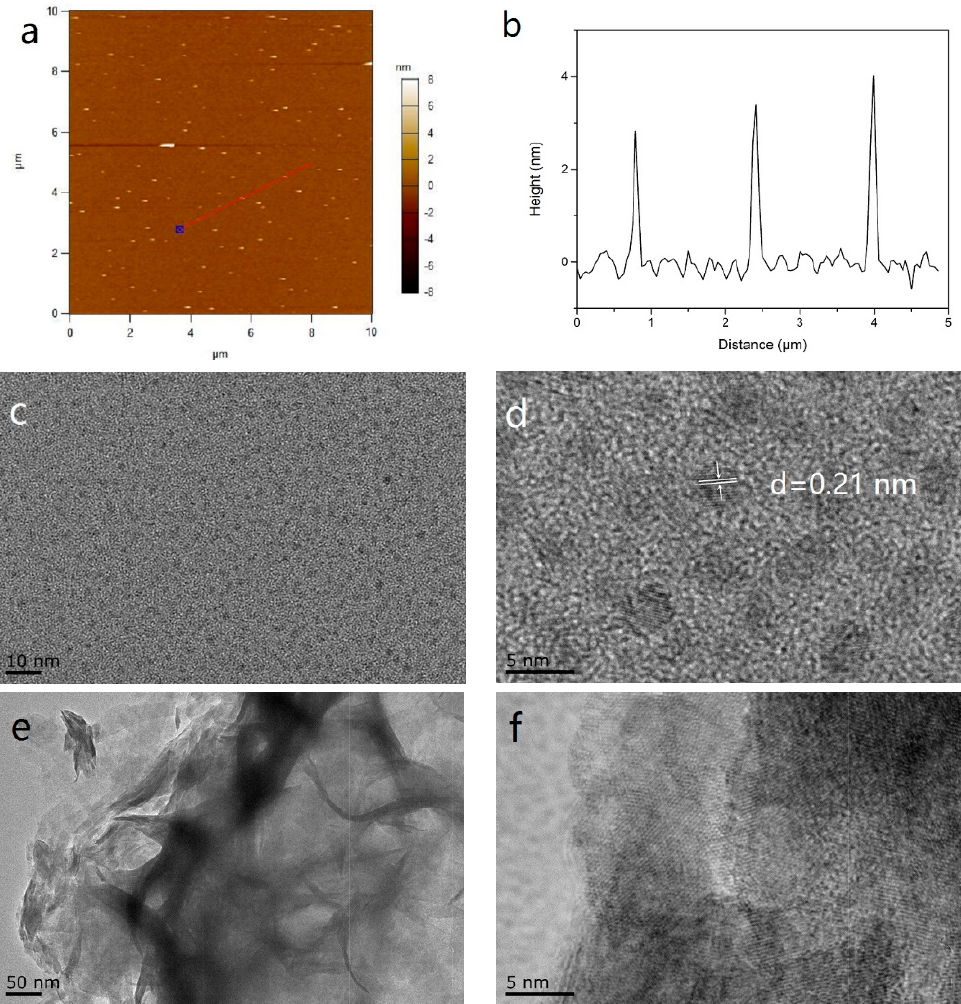
Figure 2. Morphology characterization of WS 2 QDs. ( a ) AFM (atomic force microscopy) image of WS 2 QDs; ( b ) Height profiles along the red line in ( a ); ( c ) TEM (transmission electron microscopy) and ( d ) HRTEM (high resolution transmission electron microscopy) image of WS 2 QDs; ( e ) TEM and ( f ) HRTEM image of hydrothermal synthesized WS 2 .